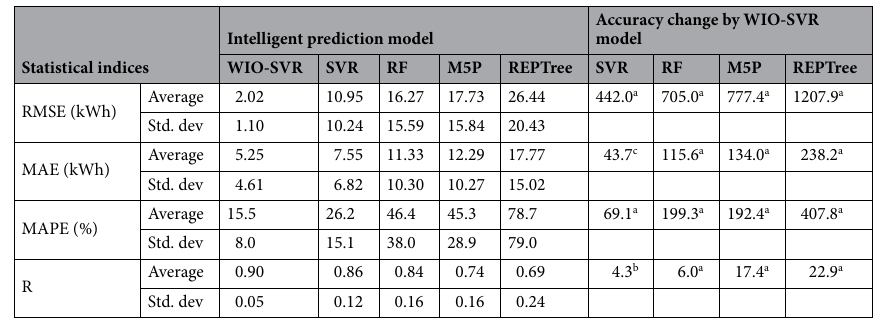
Table 6. Outstanding performance by the WIO-SVR model. a Indicates the significant level less than 1%. b Indicates the significant level less than 5%. c Indicates the significant level less than 10%.